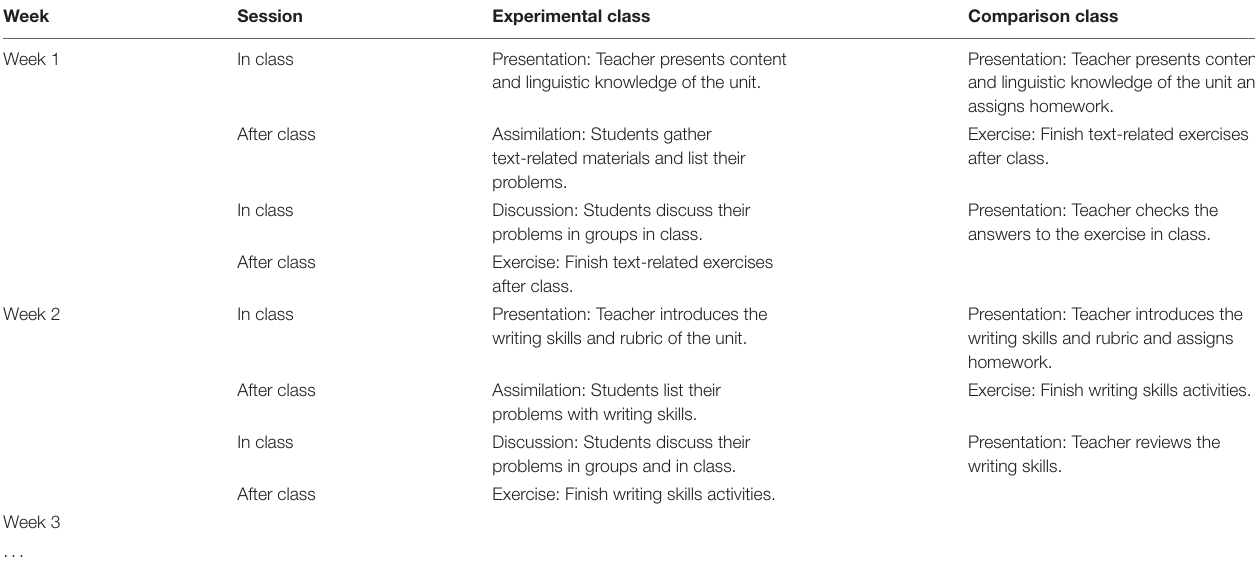
TABLE 1 | The implementation of the PADE and traditional teaching model for one unit. Week Session Experimental